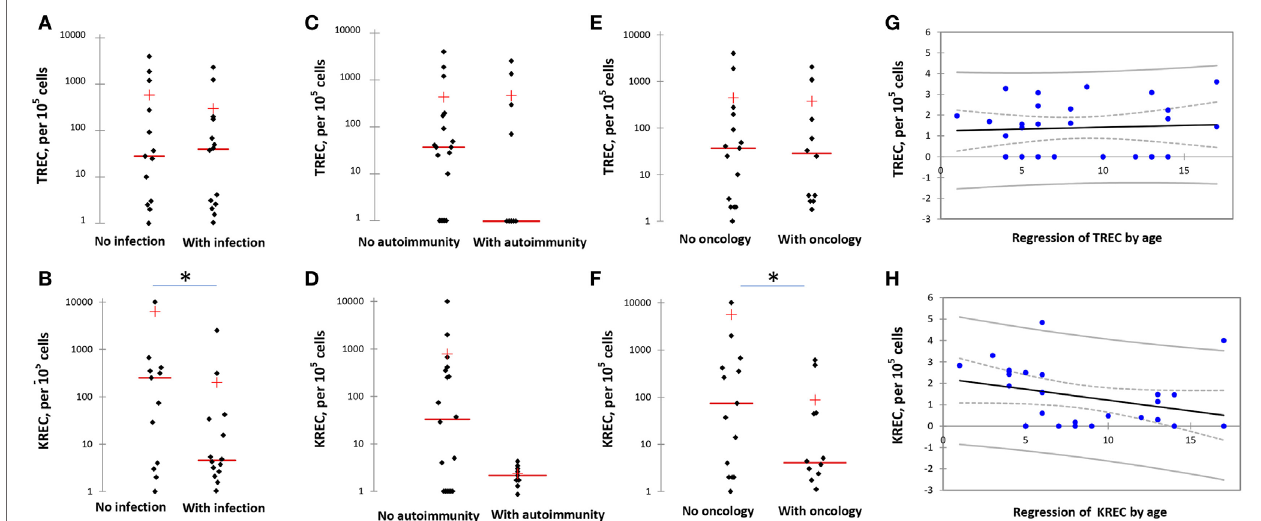
FigUre 2 | T-cell excision circle (TREC) and kappa-deleting recombination excision circle (KREC) levels in various groups of Nijmegen Breakage Syndrome (NBS) patients. (a,B) TREC and KREC levels in NBS patients with and without infection. (c,D) TREC and KREC levels in NBS patients with and without autoimmune complications. (e,F) TREC and KREC levels in NBS patients with and without malignancies. (g,h) Age-dependent distribution of TREC and KREC levels in NBS patients. Asterisk indicates statistically significant difference between the groups. TREC/KREC levels are expressed per 10 5 cells. Note logarithmical scale of the